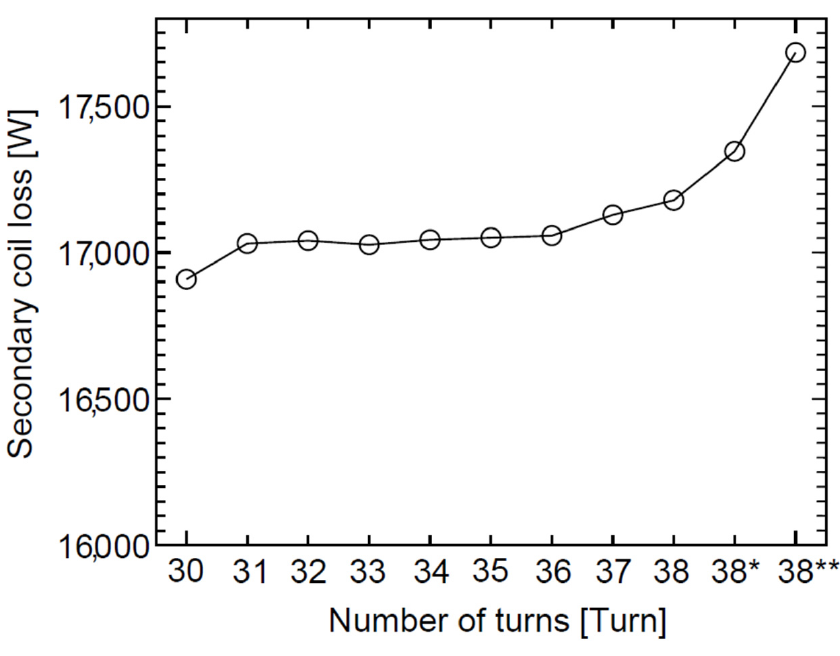
Figure 4. The secondary coil loss when the secondary winding changes.